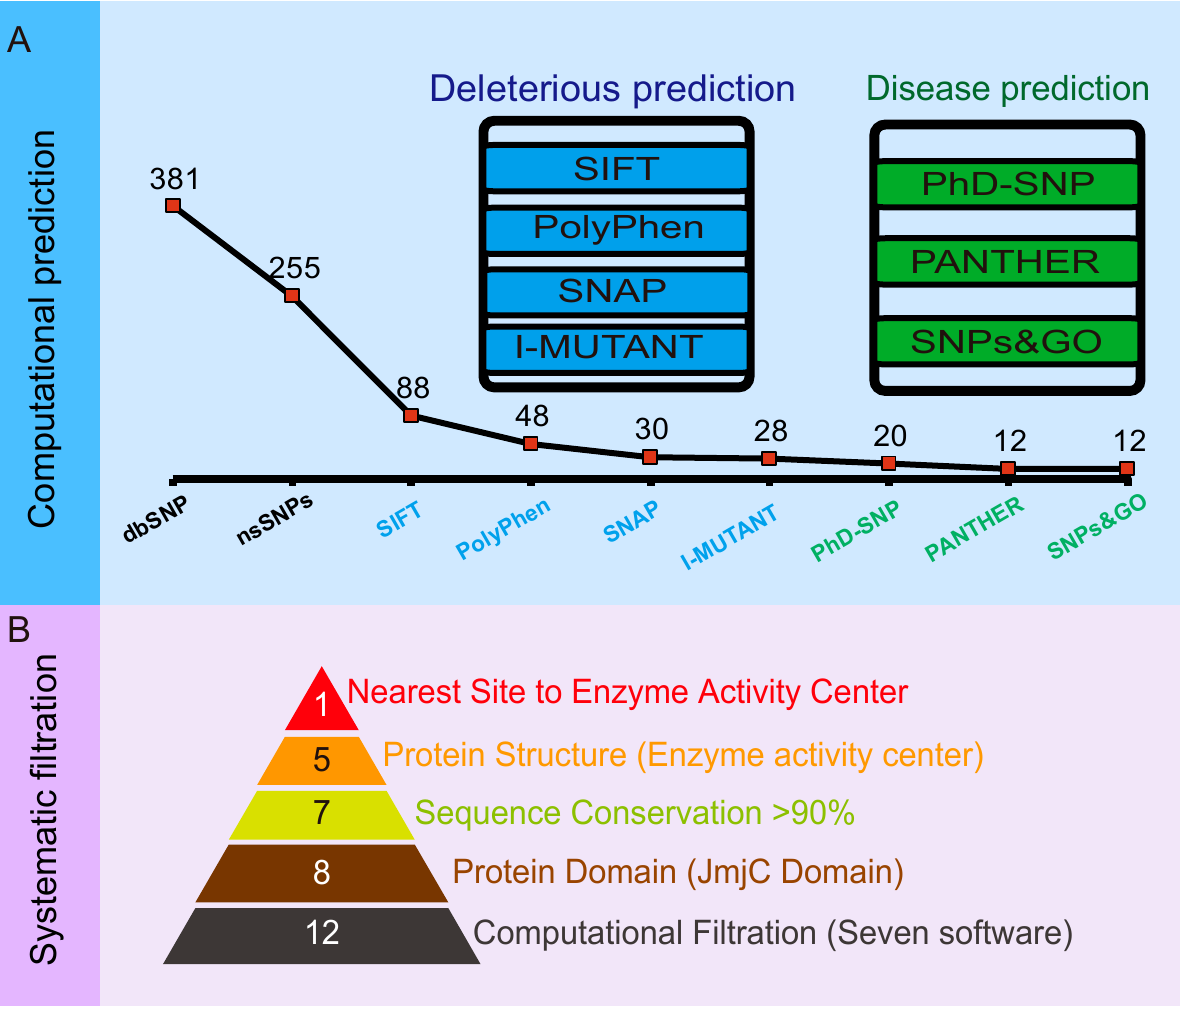
Figure 1. Schema of screening deleterious nsSNPs in JMJD6. ( A ) Computational workflow to predict deleterious nsSNPs in JMJD6. A total of 381 SNPs were retrieved from dbSNP for protein JMJD6. Firstly, SIFT, PolyPhen-2, and SNAP were conducted to predict deleterious nsSNPs based on the sequence homology and structural homology and I-Mutant 2.0 to predict the protein stability changes upon single-site mutations. Secondly, disease-associated SNPs were inferred using PhD-SNP, SNPs&GO, and PANTHER. After that, 12 candidate deleterious nsSNPs were derived by the union of seven public free nsSNP prediction softwares. ( B ) A schema of the comprehensive and systematic screening of nsSNPs in JMJD6. Under consideration of the JmjC domain and sequence conservation, as well as the three-dimensional structure of JMJD6, 5 nsSNPs (H187R, K204E, F266S, P268T, and P268A) were filtered out, and H187R was located nearest to the enzyme activity center.